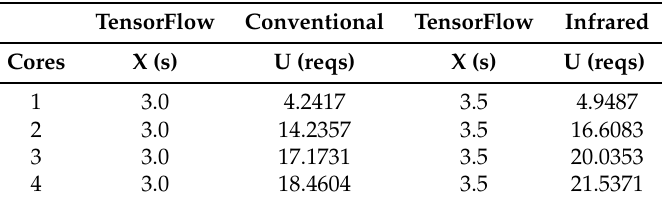
Figure 6. Infrared Tensorflow application. Table 1. Server operating